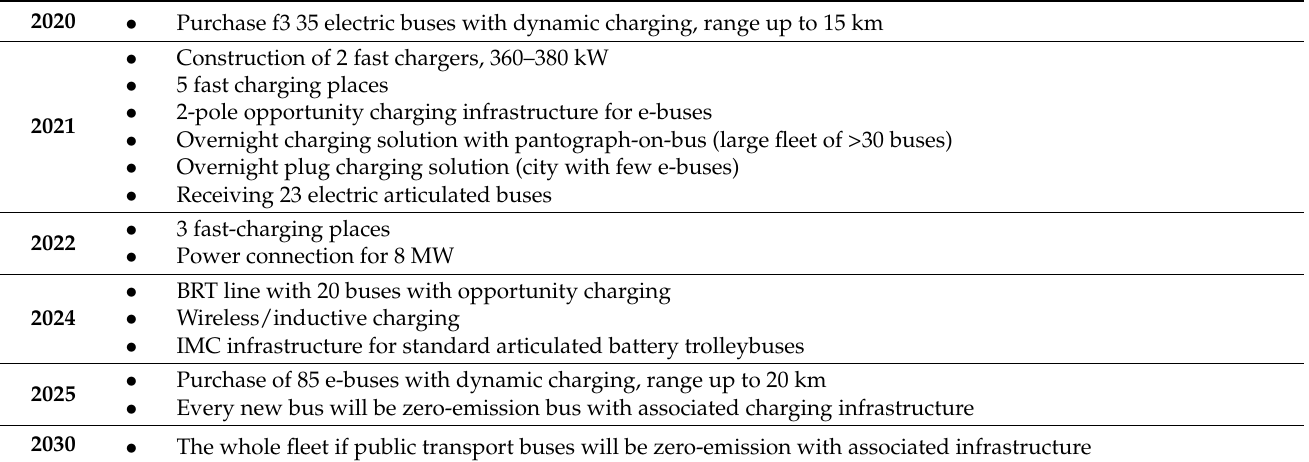
Table 6. Future goals for charging technologies in end users’ organizations.